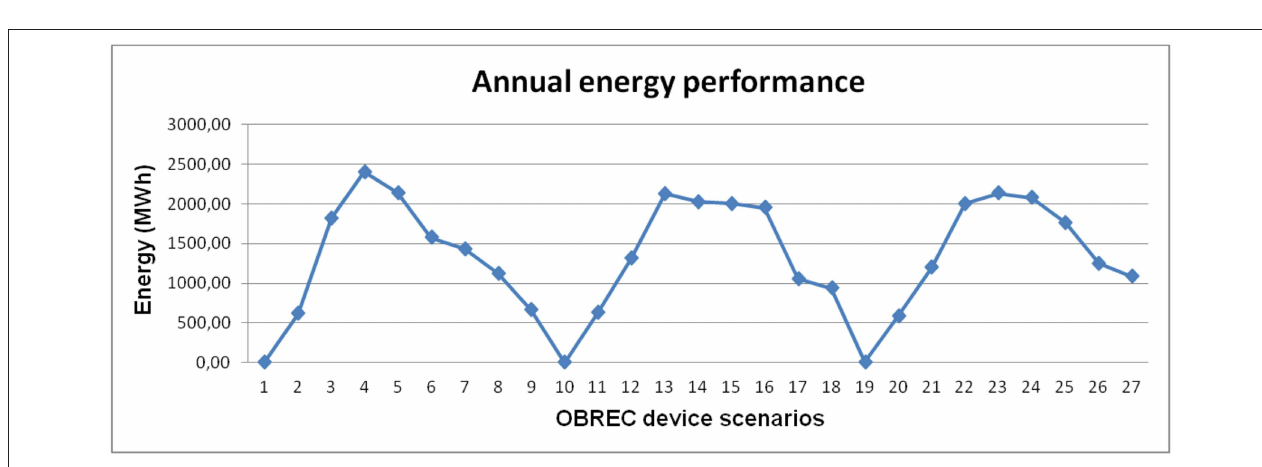
FIGURE 6 | Annual energy performance for all OBREC device